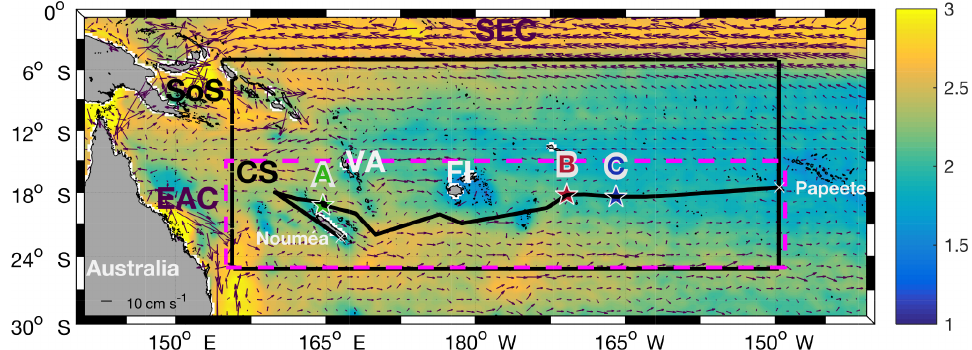
Figure 1. Mean eddy kinetic energy (log scale, colour bar) with surface velocity (arrows in cms − 1 ) computed for 10 years (2005–2015) from total altimetry-derived surface velocity field. The South Equatorial Current (SEC) and the western boundary East Australian Current (EAC) are indicated. The black line shows the ship track during OUTPACE from Nouméa to Papeete. The positions of the three long-duration (LD) stations are drawn with green, red and blue stars for LD stations A, B and C, respectively. SoS: Solomon Sea; CS: Coral Sea; VA: Vanuatu; FI: